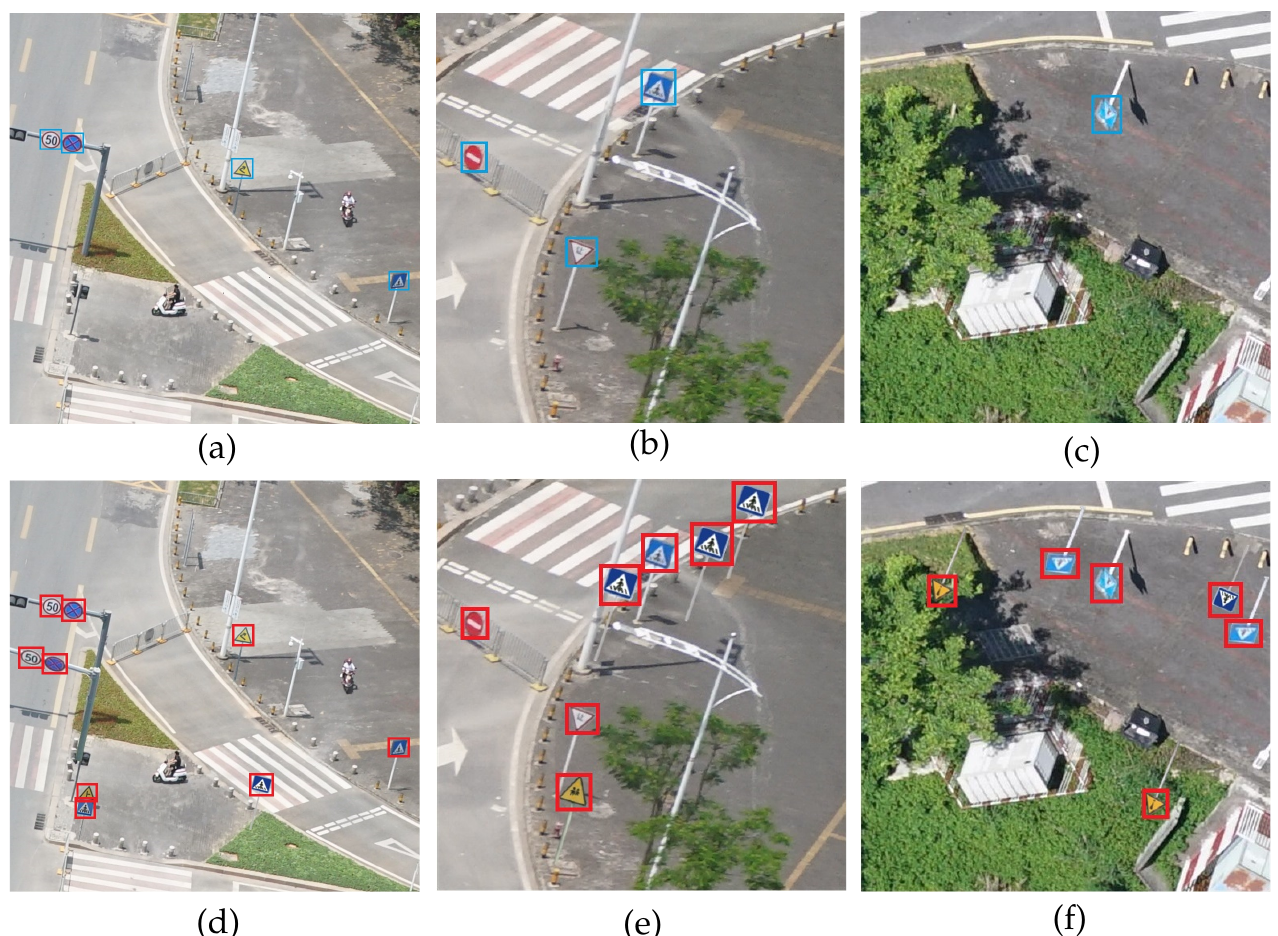
Figure 12. Comparison of training data before and after synthesis and augmentation. ( a – c ) Original oblique images, and ( d – f ) synthetic images. We cropped the training images to a pixel size of 512